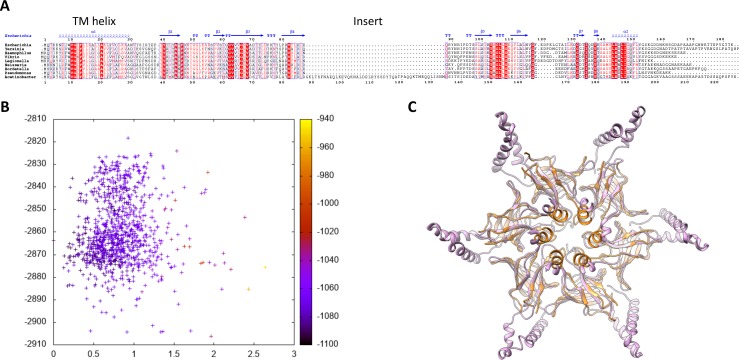
Modeling of the abMlaD hexamer.(A) Multiple alignment of MlaD sequences from various gram-negative human pathogens. The secondary structure for ecMlaD is shown at the top. The position of the abMlaD insert is indicated. (B) Result of the all-atom refinement step for the MlaD hexameric model. The energy of each model is plotted versus the RMSD relative to the initial model and color-coded for the fit to the EM map density. (C) Cartoon representation of our abMlaD hexameric model (magenta), superimposed to the crystallographic ecMlaD hexamer structure (orange).